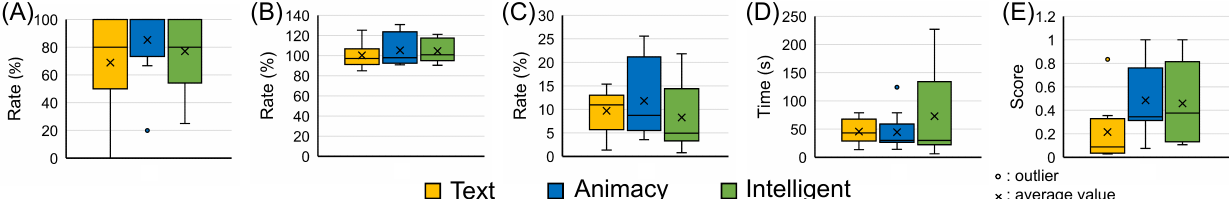
Figure 8. Results of objective evaluation. ( A ) Subtask success rate (%). ( B ) Relative change of the LF/HF ratio (%). ( C ) Percentage of time spent looking at the refrigerator while seated (%). ( D ) Time interval from state visualization to leaving the seat (s). ( E ) Action timing